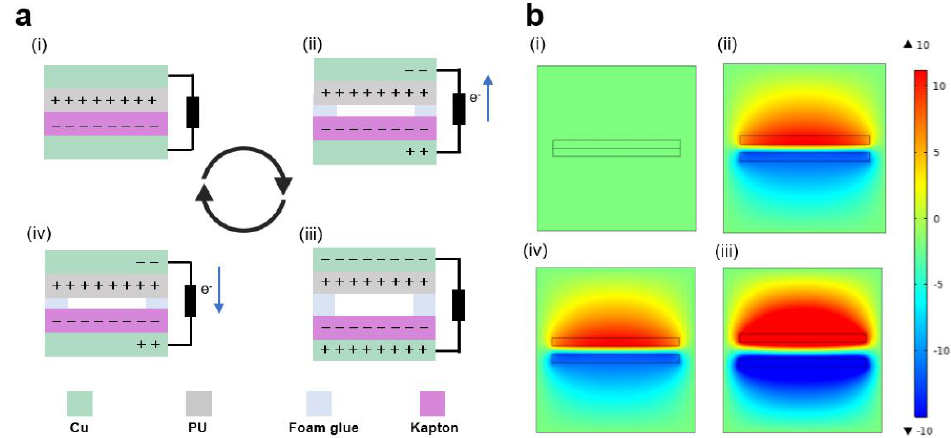
Figure 2. Working mechanism of the TENG ( a ) Working principle of the TENG. ( i ) The PL-TENG is compressed. ( ii ) The triboelectric layer of the PL-TENG gradually separates. ( iii ) The triboelectric layer of the PL-TENG is completely separated. ( iv ) The PL-TENG is compressed, and its triboelectric layer is gradually approached. ( b ) COMSOL software demonstrates the working principle of the PL-TENG. ( i ) the PL-TENG is compressed. ( ii ) The triboelectric layer of the PL-TENG gradually separates. ( iii ) The triboelectric layer of the PL-TENG is completely separated. ( iv ) Under an external force, the friction layer of the PL-TENG moves close again.